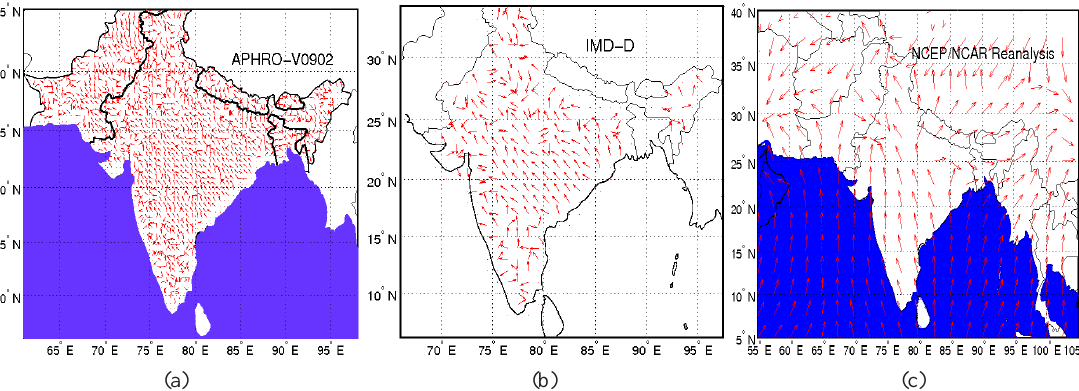
Fig. 7. (a) Time delay patterns as obtained form APHRO-V0902 for α =94%. (b) Time delay patterns as obtained form IMD-D for α =94%. (c) Mean wind direction at the height of 850hPa during rain events above the threshold of α =94%, derived from NCEP/NCAR data set with Fig. 7: (a) Time delay patterns as obtained form APHRO–V0902 for α = 94% (b) Time delay patterns as obtained form IMD-D time indices for the events calculated from NCEP/NCAR precipitation for α = 94% (c) Mean wind direction at the height of 850 hPa during rain events above the threshold of α = 94% , derived from NCEP/NCAR data set with time indices for the events calculated from NCEP/NCAR precipitation data